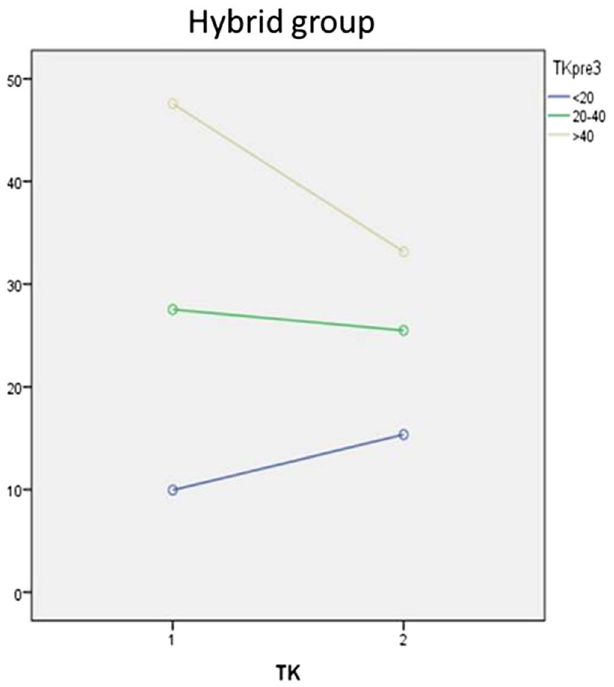
Figure 4. Thoracic Kyphosis correction in Group 2 (Hybrid), statistical analysis performed using IBM SPSS Statistics